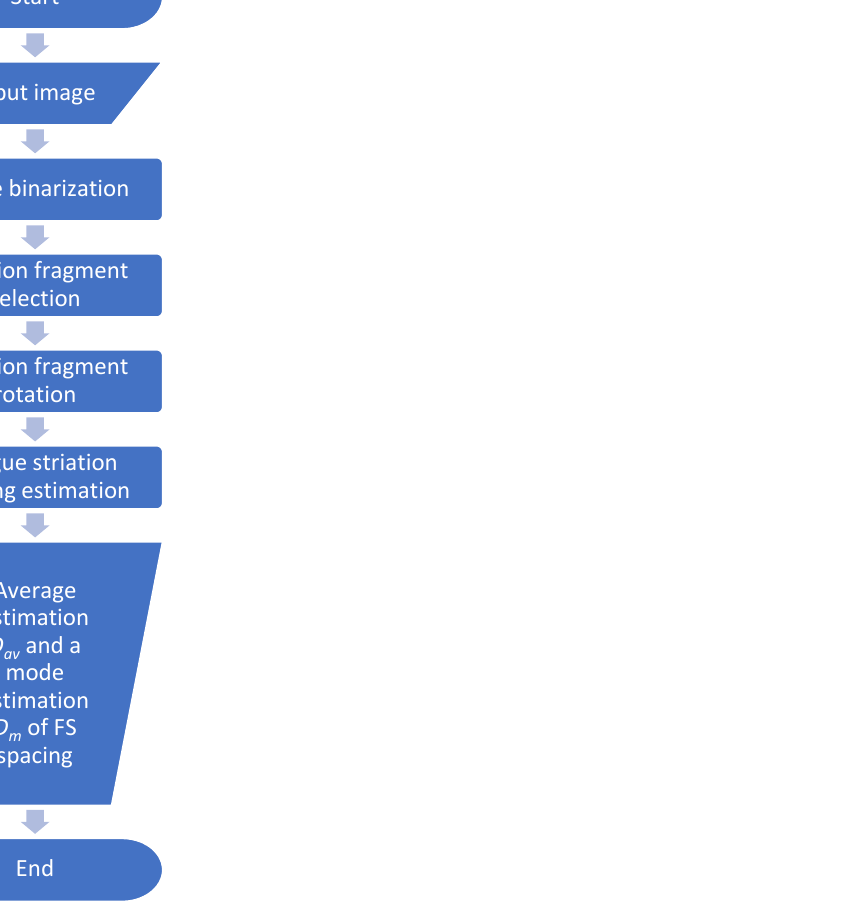
( b ) Figure 4. Binary image obtained after iterative selection of local minima ( a ), and the result of its morphological processing ( b ). In this case, 𝐵⨁𝑆 is the set of all displacements 𝑏 of the structural element 𝑆 in image 𝐵 , at which 𝑆 and 𝐵 are overlaped by at least one element. The visual effect of dilation is the thickening of lines. Then the thinning operation to the obtained binary image was applied (Figure 4b), from which it is already possible to determine the fatigue striation spacing. Consecutive application of morphological dilation and thinning operations allows us to remove gaps in lines. An average estimation 𝐷 (cid:3028)(cid:3049) and a mode estimation 𝐷 (cid:3040) of the fatigue striation spacing were proposed. The average estimation is calculated as the area of the image 𝑆 (cid:3036)(cid:3040) divided by the length of all these lines corresponding to the striations. The total length of the lines is calculated as the number of non-zero pixels 𝑁 (cid:3043) . Thus, the average estimation was calculated as: 𝐷 (cid:3028)(cid:3049) = 𝑆 (cid:3036)(cid:3040) /𝑁 (cid:3043) .